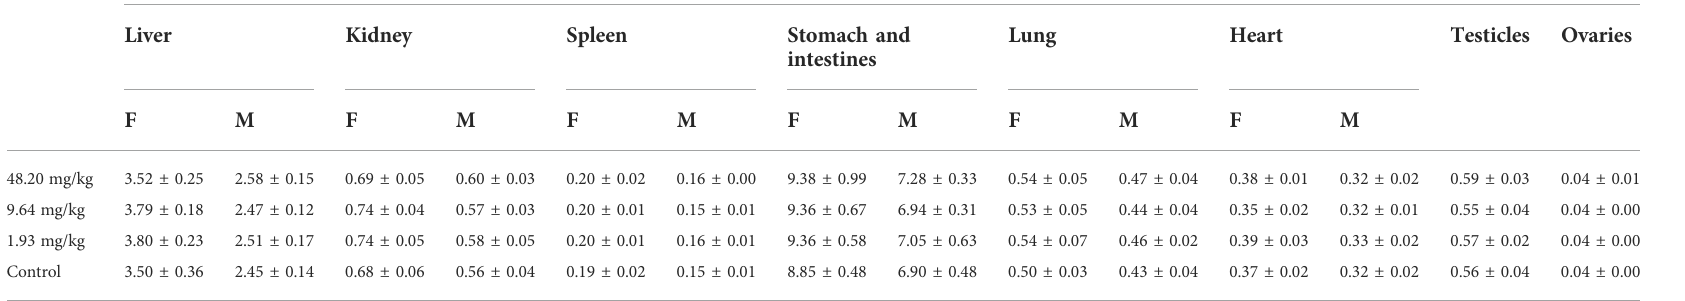
TABLE 9 Effect of MPTA on organ coef fi cients in rats. Groups Organ coef fi cient (%) Kidney Spleen Stomach and